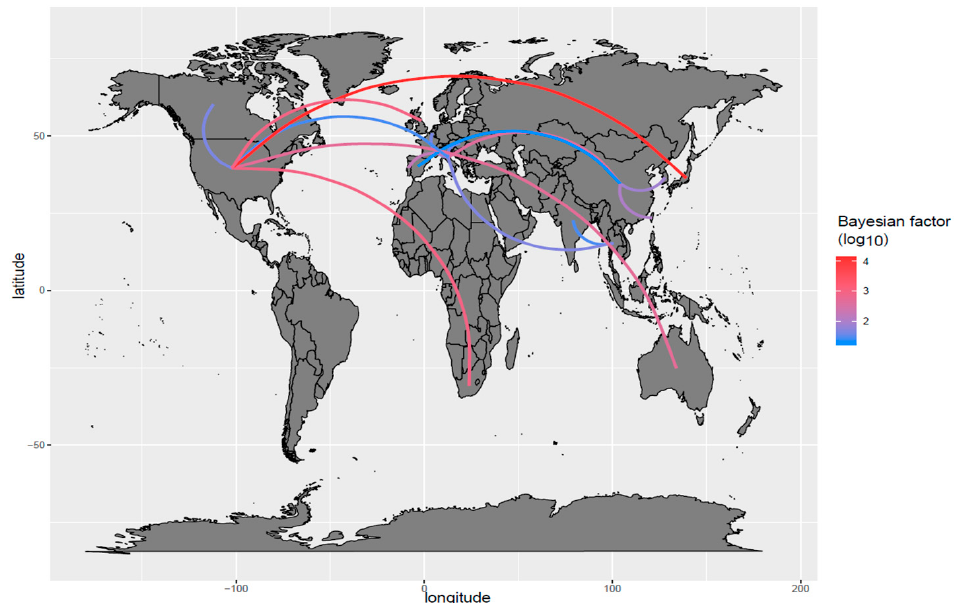
Figure 2. Maximum clade credibility tree phylogenetic trees reconstructed on the International ( a ) and Study ( b ) datasets. The geographical origin of the sequences (i.e., collection country 2a; Italian province 2b) is color-coded.